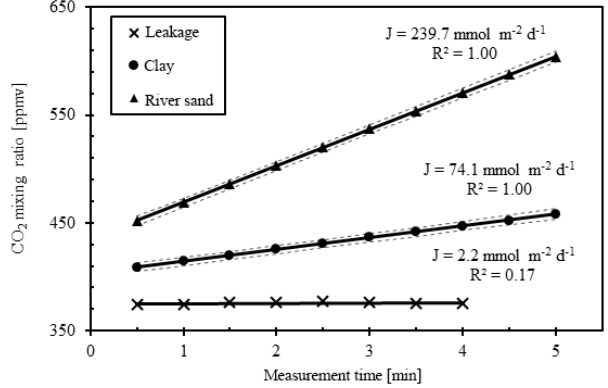
Figure 3. Example showing typical progression of CO 2 concentra- tion during field measurements with clay and ambient material (ex- ample: river sand site). For “leakage” measurements the chamber was placed on the sediment without applying any sealing material (small holes were visible). Dotted lines indicate 99.9999% error